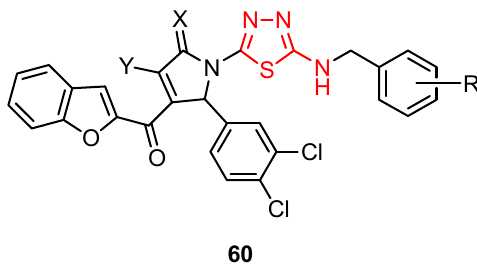
Figure 9. The general formula of derivatives 60.